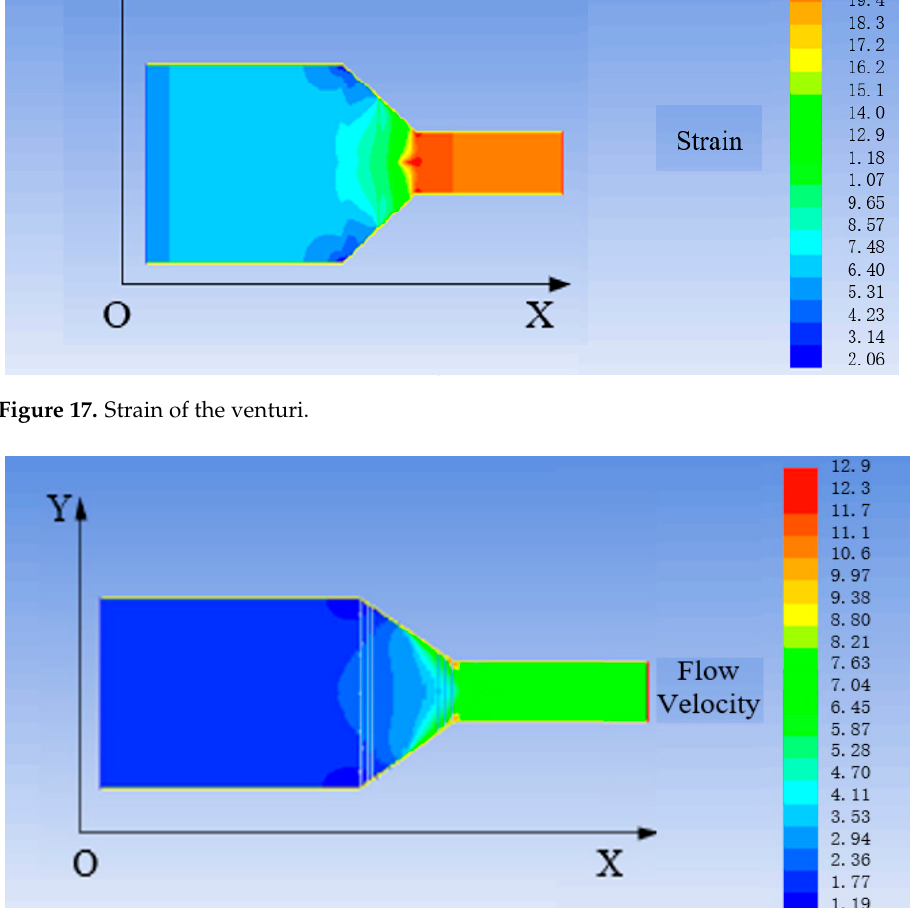
Figure 18. Change of the flow velocity (unit: m/s).